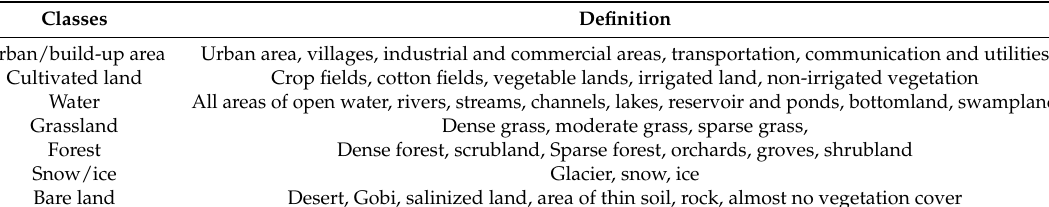
Table 2. Classification of land types in this study.